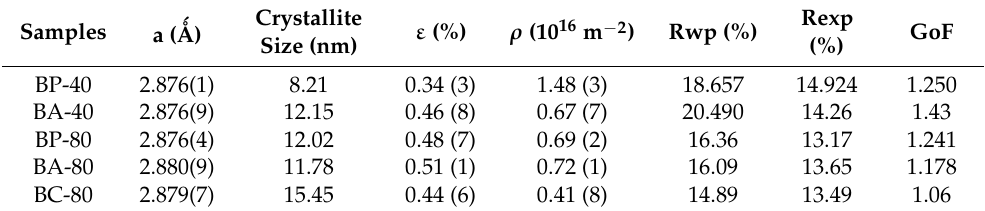
Table 3. Crystallographic parameters and Rietveld refinement results obtained by Rietveld refinement of the B (Fe 80 Nb 8 B 12 )